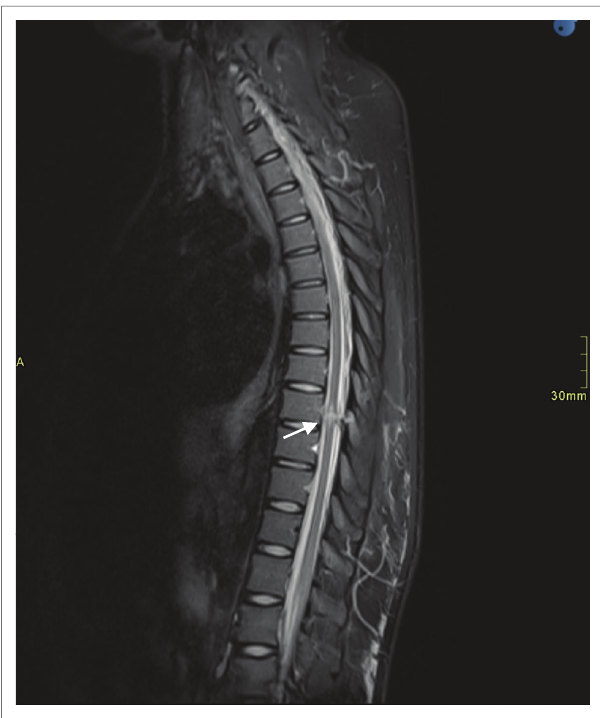
FIGURE 3: Sagittal T2 short tau inversion recovery image demonstrating high T2 signal wound tract, cord oedema and cord signal changes in the thoracic spine (arrow).